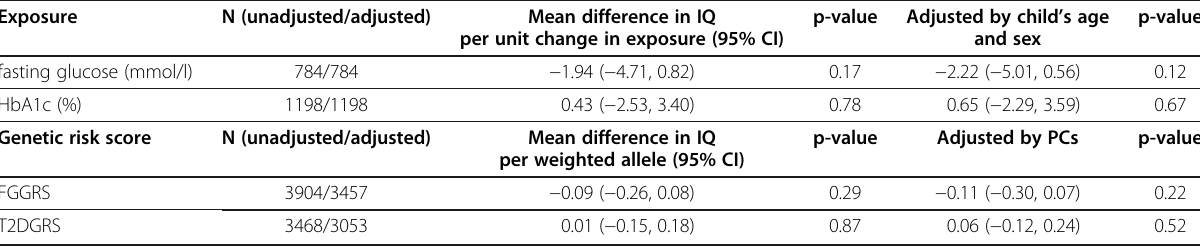
T2DGRS 3468/3053 FGGRS = fasting glucose genetic risk score. T2DGRS = type 2 diabetes genetic risk score. PCs = population stratification principal